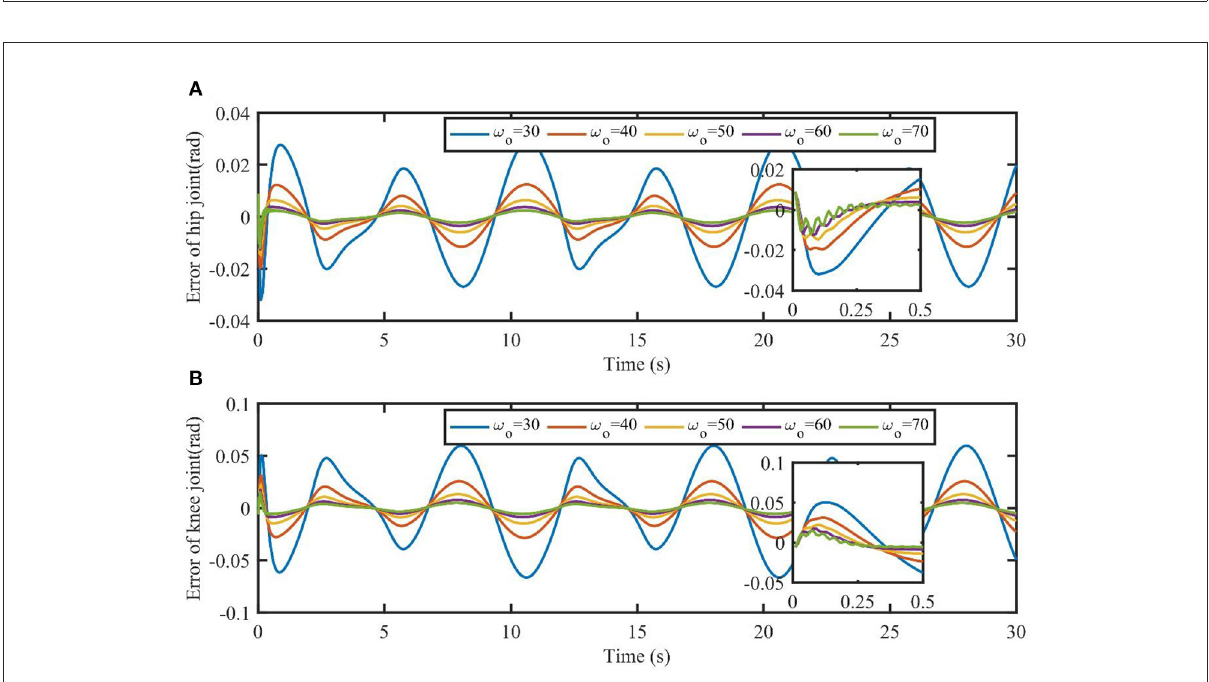
FIGURE5 Tracking errors of TSC-LADRC under different values of ω o . The part plots are the initial response of joints’ tracking errors in the time interval [0,